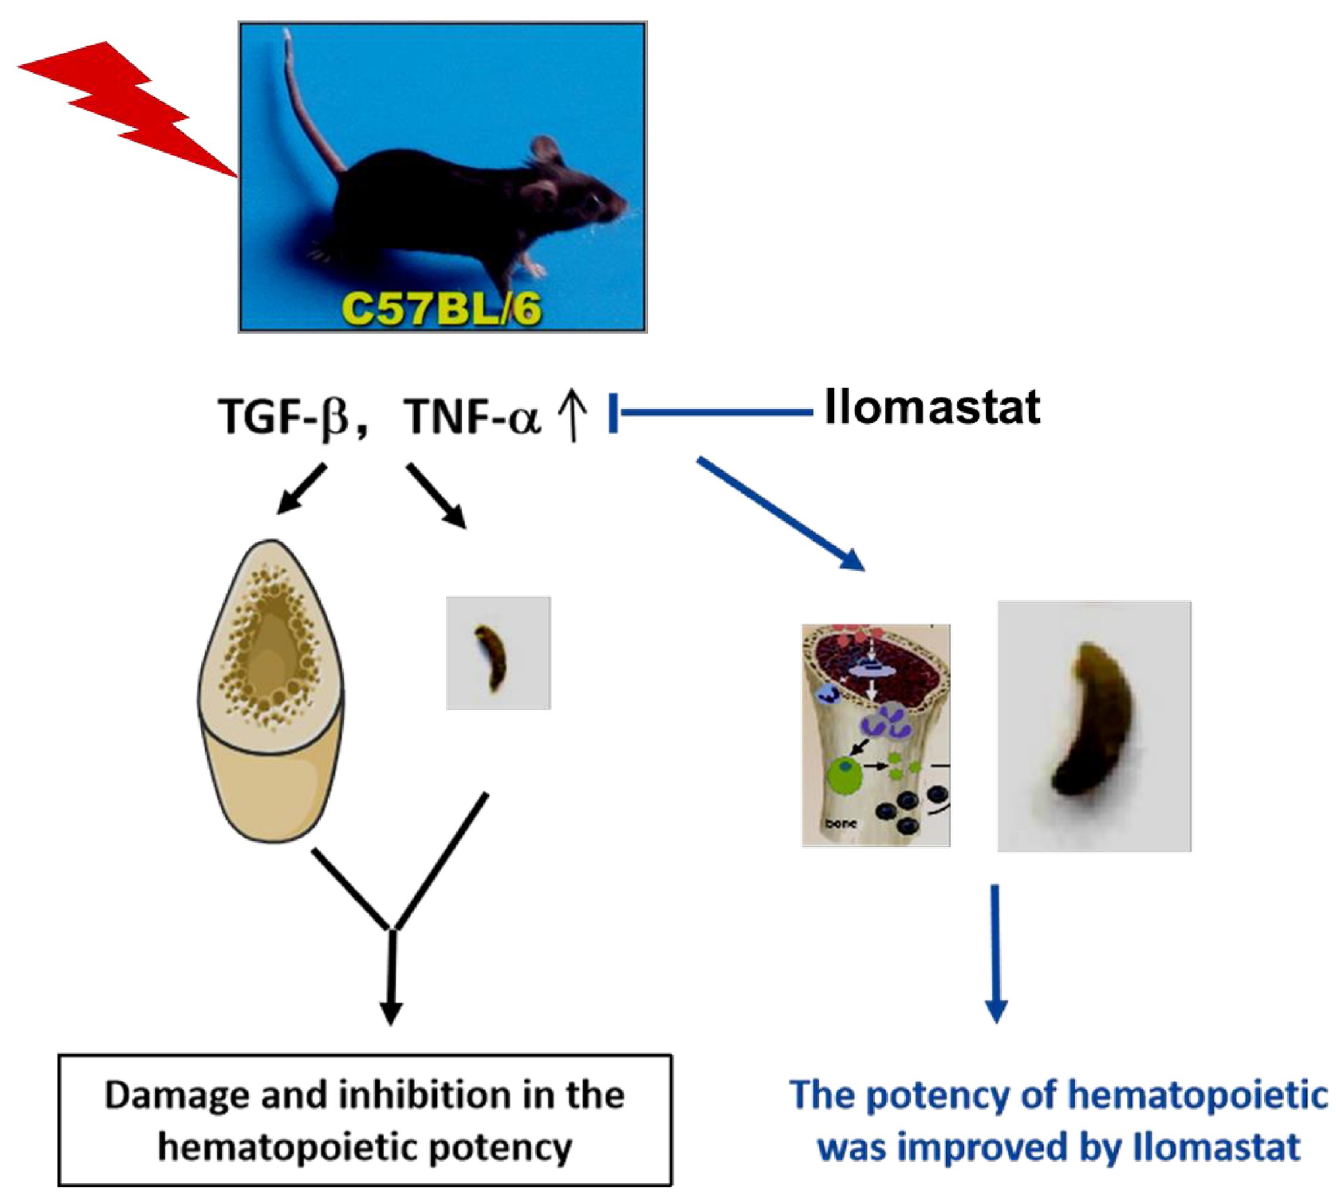
Fig 7. The speculated model of Ilomastat promoting the recovery of radiation-induced hematopoietic injury in mice. Ilomastat pretreatment decreases the TGF- β 1 and TNF- α and increases the hematopoietic growth factor, directly or indirectly. Eventually, promote the recovery of radiation-induced hematopoietic injury.